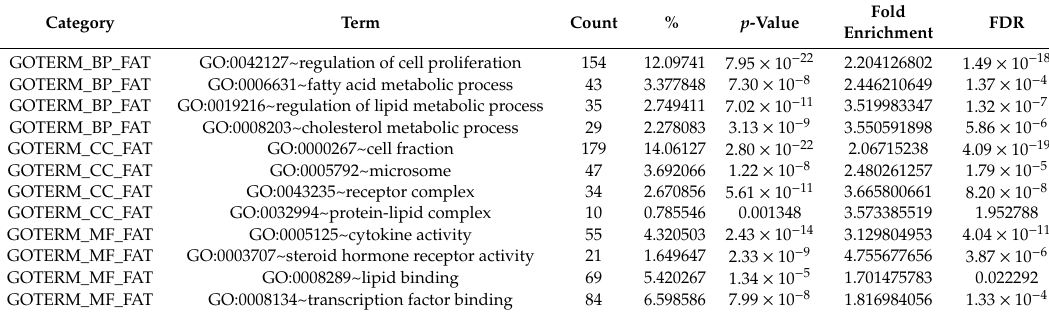
Table 3. Gene Ontology (GO) enrichment analyses of DE miRNA gene targets associated with lipid metabolism and fat